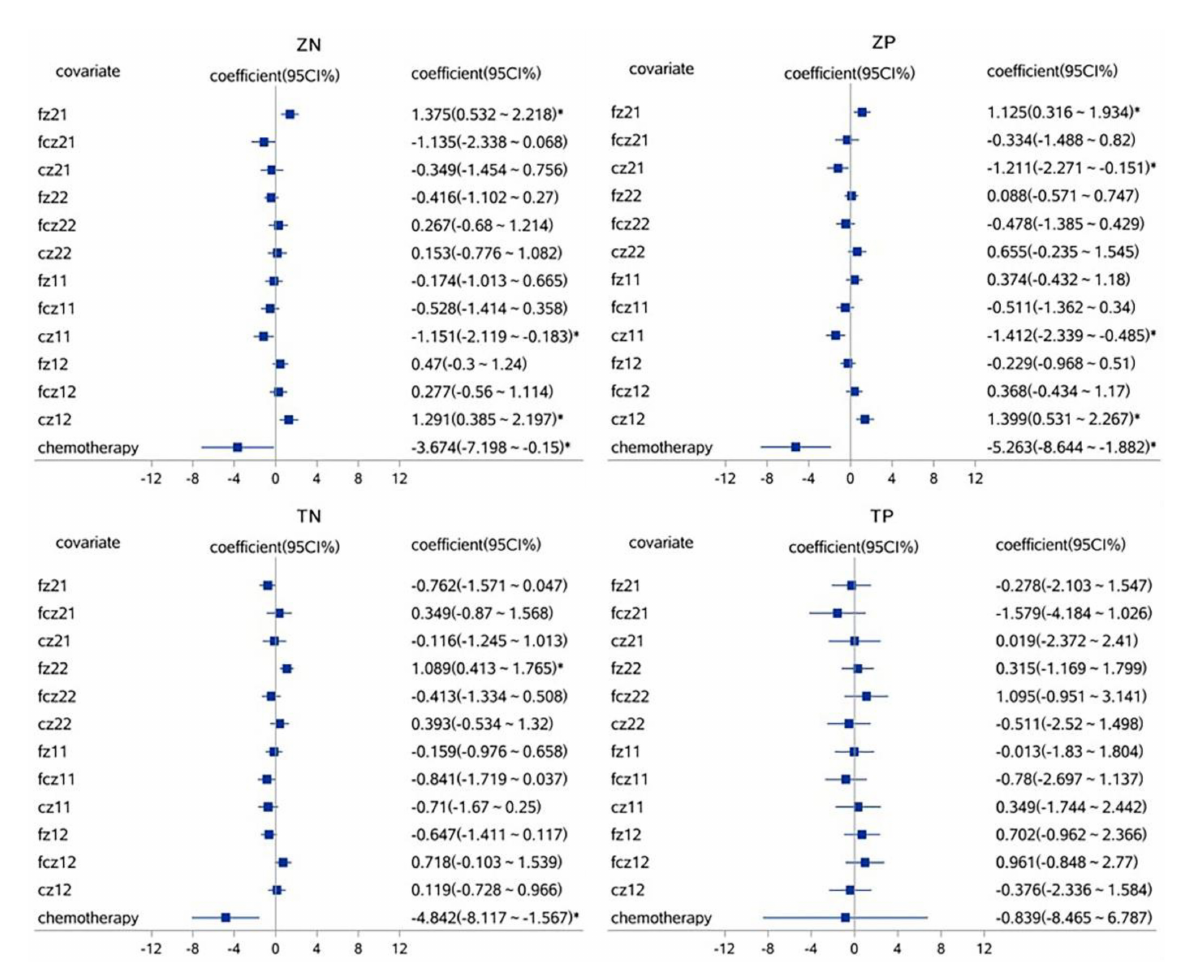
FIGURE4 The correlations analysis between ERP P2 component and accuracy rates on pain empathy paradigm. * P < 0.05, linear mixed effect model, when 95% confidence interval (95 CI%) contained no 0 in the forest plots, that is, the minimum value for the interval was positive or the maximum was negative, then P < 0.05. fz, fcz, and cz were defined as electrode points for ERP. Z, laterality tasks; T, pain task; N, neutral picture stimulation; P, pain picture stimulation. 21, laterality tasks + pain picture stimulation; 22, laterality tasks + neutral picture stimulation; 11, pain task + pain picture stimulation; 12, pain task + neutral picture